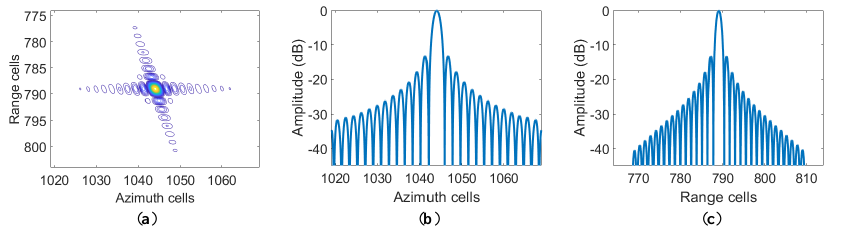
Figure 17. The imagery quality assessment for second GMT after accurate focusing. ( a ) 2-D responses. ( b ) Azimuth responses. ( c ) Range